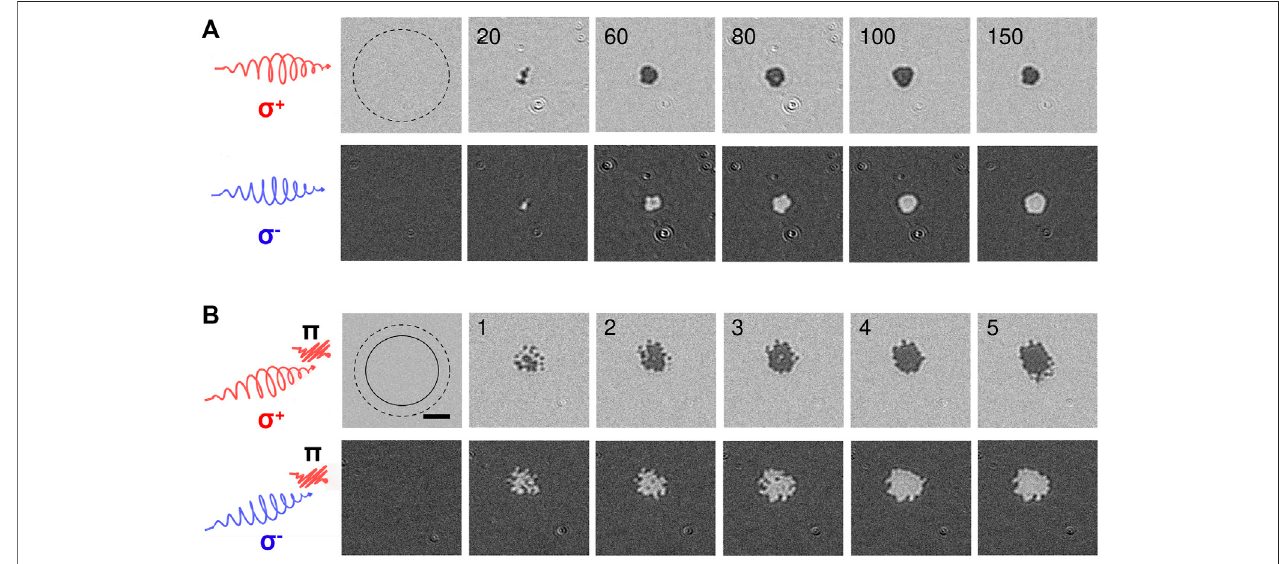
FIGURE1| Dual-pulseall-opticalhelicitydependentswitching(AO-HDS). (A) AO-HDSbymultipleright( σ + )andleft( σ − )circularlypolarizedpulses.Here,the fl uence ofthe 3.0-ps σ pulse was fi xed at F σ = 3.42 mJ/cm 2 . (B) Dual-pulse AO-HDS for time separation Δ t of5.0 ps. Here, weused the fl uence of F π = 2.32 mJ/cm 2 for the 90-fs π pulse and F σ = 1.94 mJ/cm 2 for the 3.0-ps σ pulse. The number of pulse (pairs) is indicated on each magneto-optical image. The darker and brighter areas denote up( M ↑ )- and down( M ↓ )-magnetized states, respectively. The scale bars correspond to 20 µm. The 1/e 2 diameter of the σ (solid line) and π (dash line) pulses were 52.0 ± 0.8 and 68.2 ± 1.8 μ m, respectively.